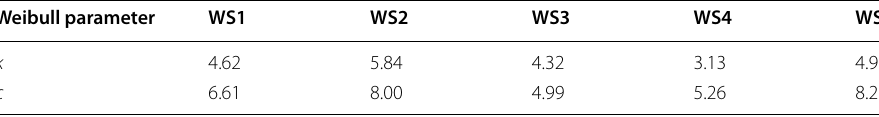
Table 3 Parameters of Weibull distribution for wind speed